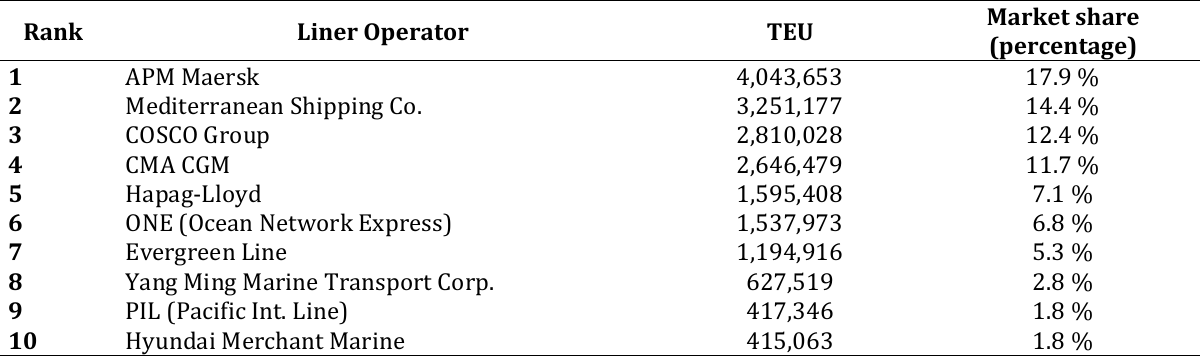
Table 1: Global top 10 liner shipping companies